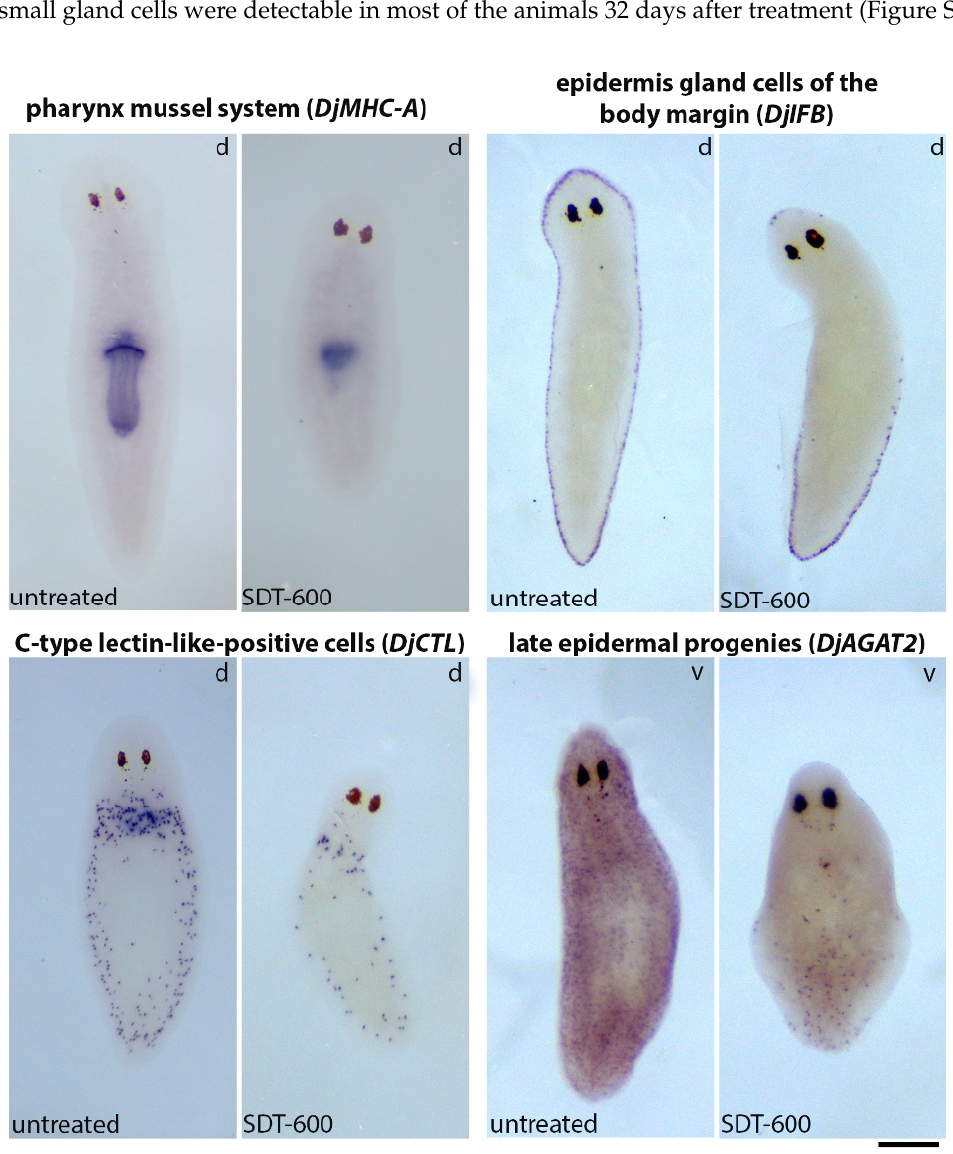
Figure 8. Analysis of the expression of differentiated tissue markers in untreated controls and in SDT-600 animals sacrificed 26 days after treatment. Scale bar corresponds to 500 μm.